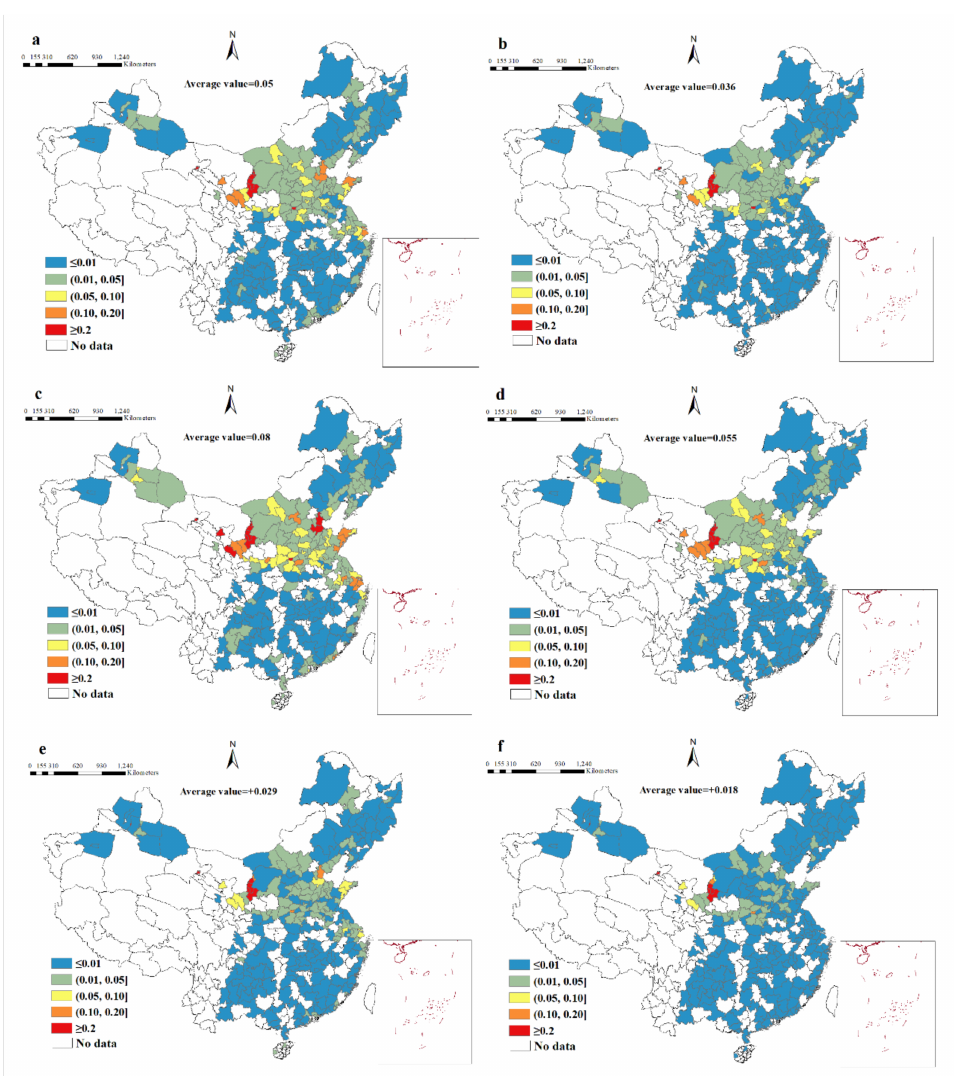
Figure 4. Withdrawal- and consumption-based water stress index levels of 234 cities in China in 2018; ( a ) withdrawal based current water stress index levels without CCS. ( b ) Consumption-based